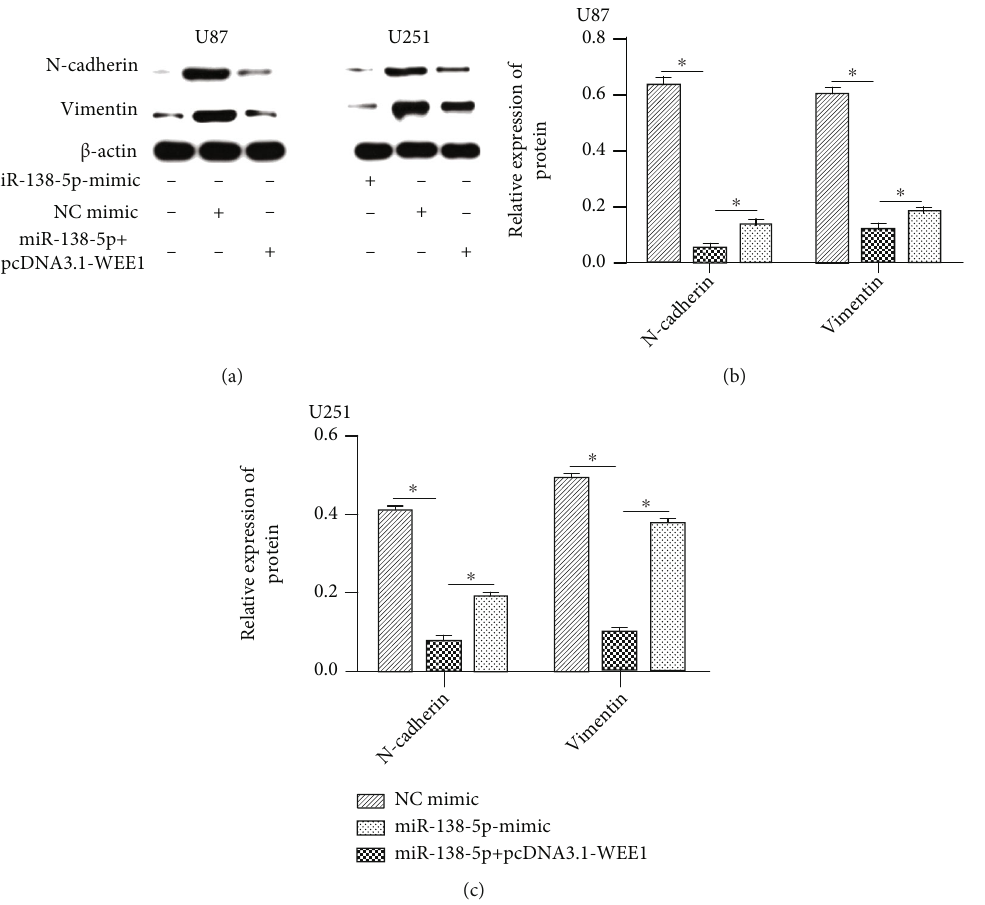
Figure 8: The expression of WEE1 inhibited miR-138-5p-induced N-cadherin and vimentin expression. (a) Expression of N-cadherin and vimentin in U87 and U251 cells in each treatment group was determined using western blot. (b, c) The inhibition of N-cadherin and vimentin expression was reversed with the cotransfection of miR-138-5p and pcDNA3.1-WEE1. Each experiment was repeated at least three times. ∗ P < 0 : 05